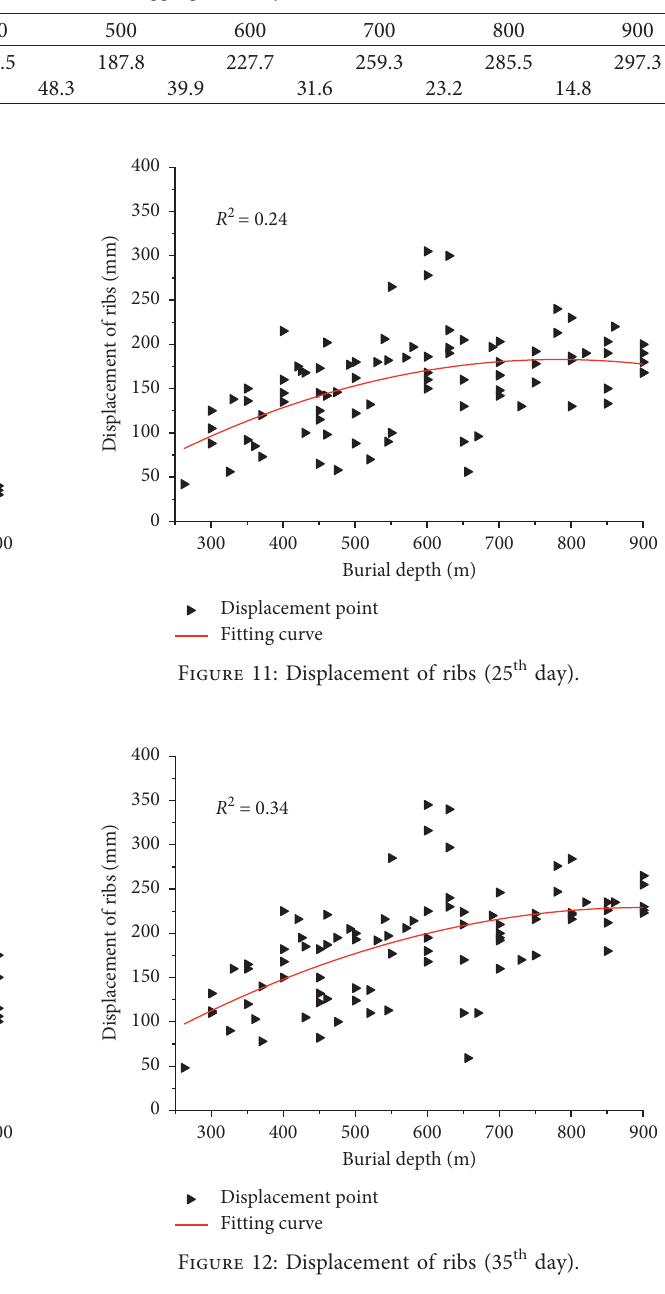
Table 1: Comparison of displacement of new digging roadway roof to floor.